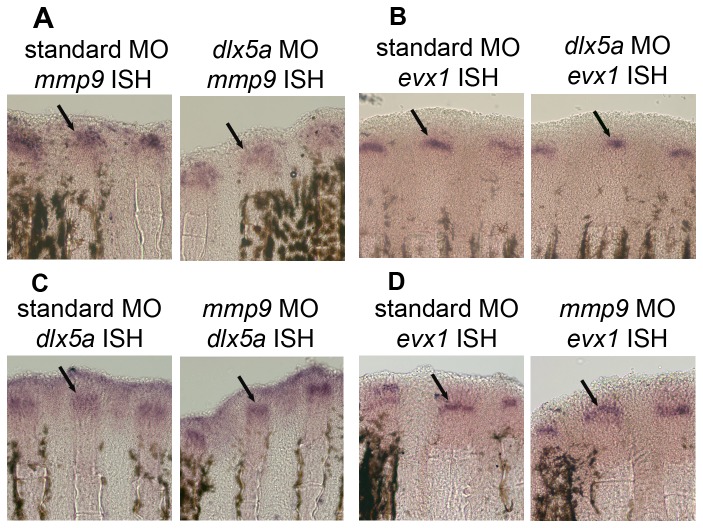
Confirmation of the predicted evx1-dependent joint pathway.Morpholino-mediated gene knockdown followed by whole mount ISH show that dlx5a-knockdown causes reduced mmp9 expression (A) but does not influence evx1 expression (B). mmp9-knockdown does not influence dlx5a expression (C) or evx1 expression (D). Arrows point to the in situ hybridization staining.